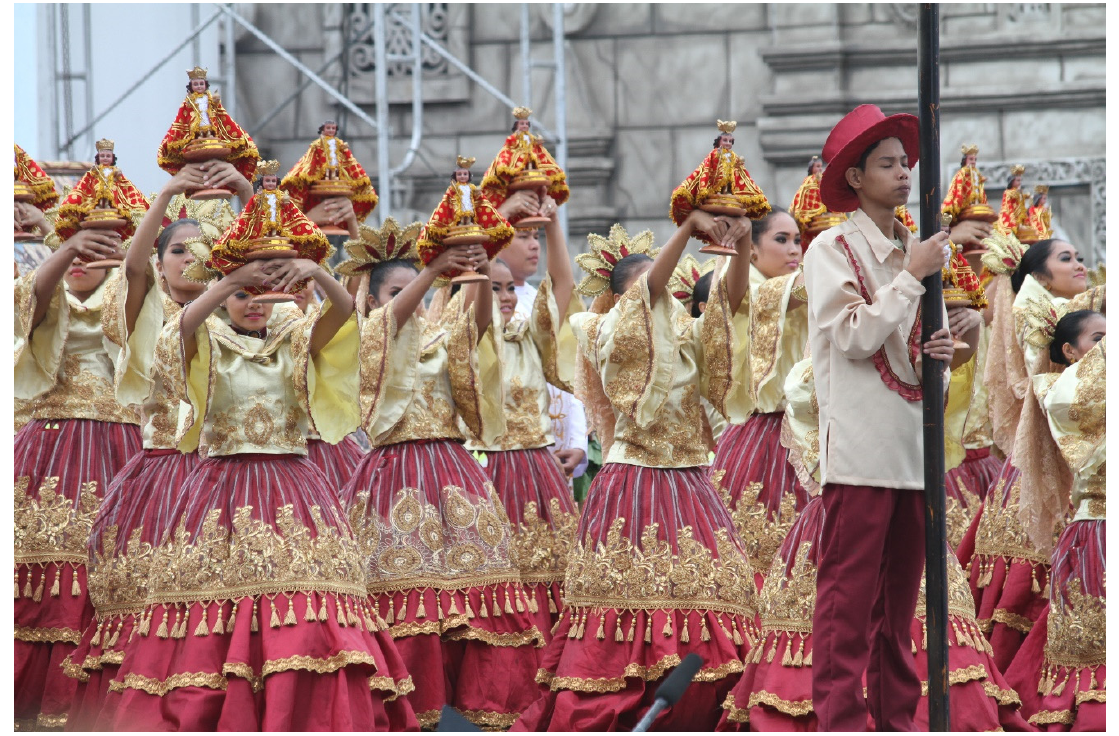
Figure 2. The “troupe Sinulog” featuring replicas of the Santo Niño. Source: Wikimedia Commons, photo by Jescario.